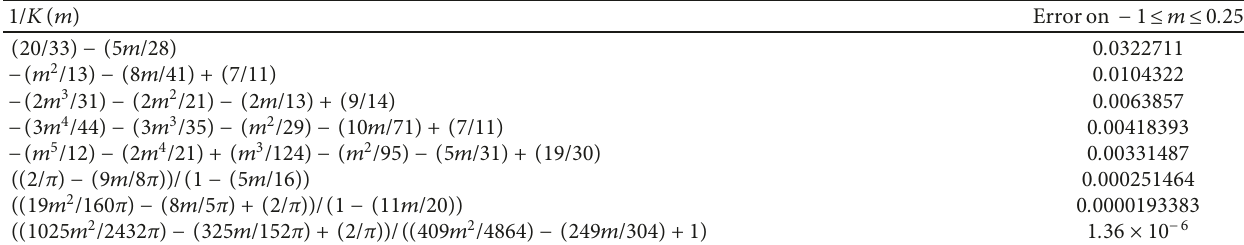
Table 2: Approximate trigonometric solution to the i.v.p. (1) may be obtained in many ways. 1/ K ( m ) Error on − 1 ≤ m ≤ 0 . 25